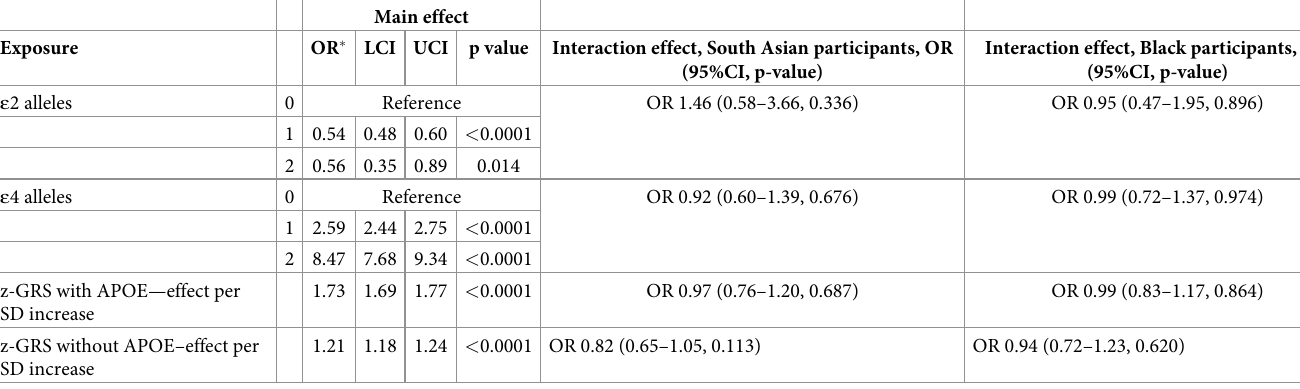
Table 2. Dementia risk associated with genotype by self-defined ethnicity.